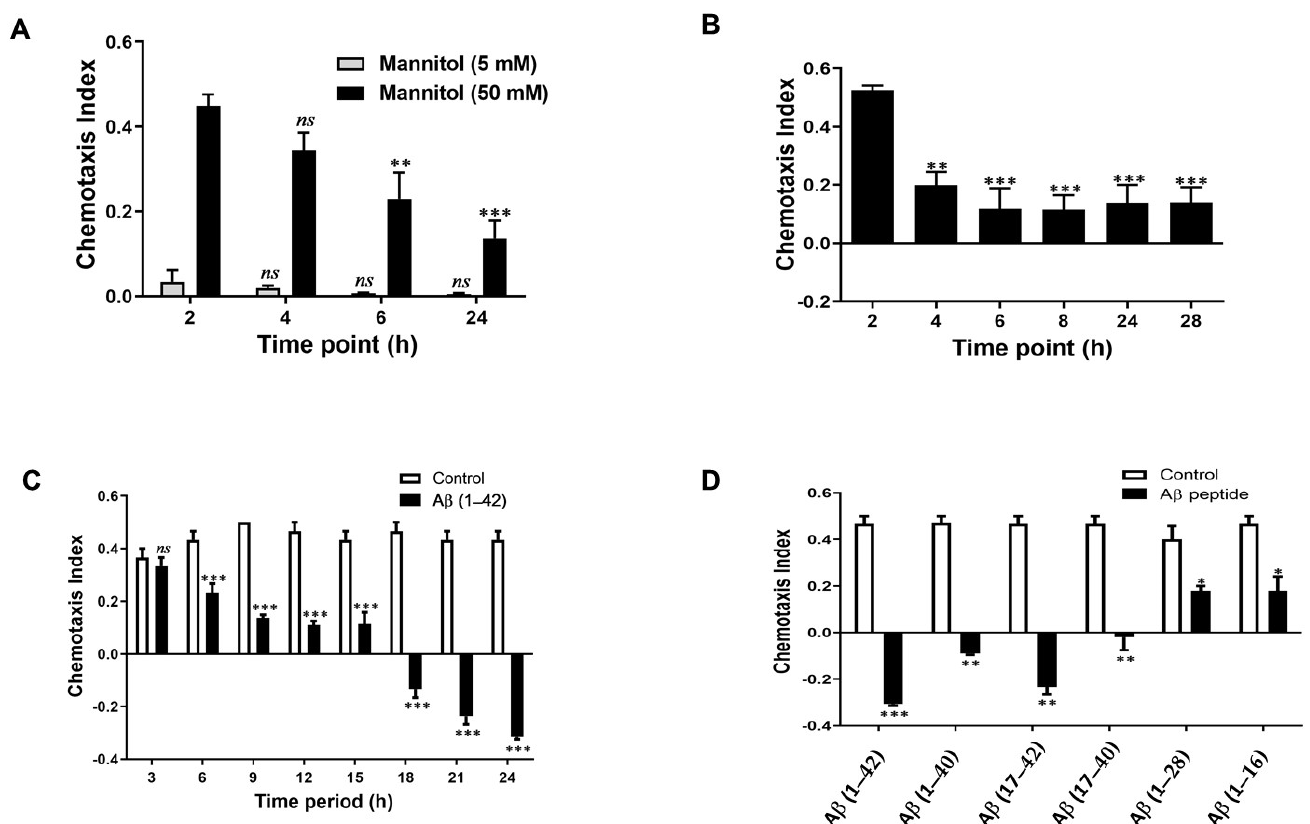
Figure 1. Optimising assays for chemotaxis index (CI) of G. pallida in function of ( A ) different concentrations of mannitol (chemoattractant) with CI measured at 2, 4, 6, and 24 h; ( B ) a range of incubation periods in response to mannitol (50 mM). G. pallida had the greatest CI to mannitol at 2 h; this effect gradually diminished with increasing incubation time; ( C ) the duration of the A β (1–42) pre-incubation, which determines the extent to which the CI was affected. Pre-incubations as short as 6 h significantly affected CI, with the most pronounced effects observed at 18 h and 24 h; ( D ) A β fragment peptides in untreated G. pallida . The data are mean ± SEM ( n = 3). ns (not significant), * p < 0.05, ** p < 0.01, and *** p < 0.001, compared with control .